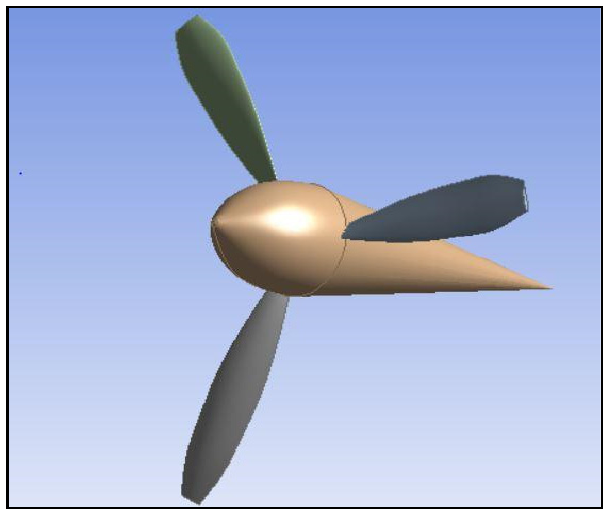
Figure 25. Propeller 3D model. Table 15. Boundary conditions for thrust calculations.